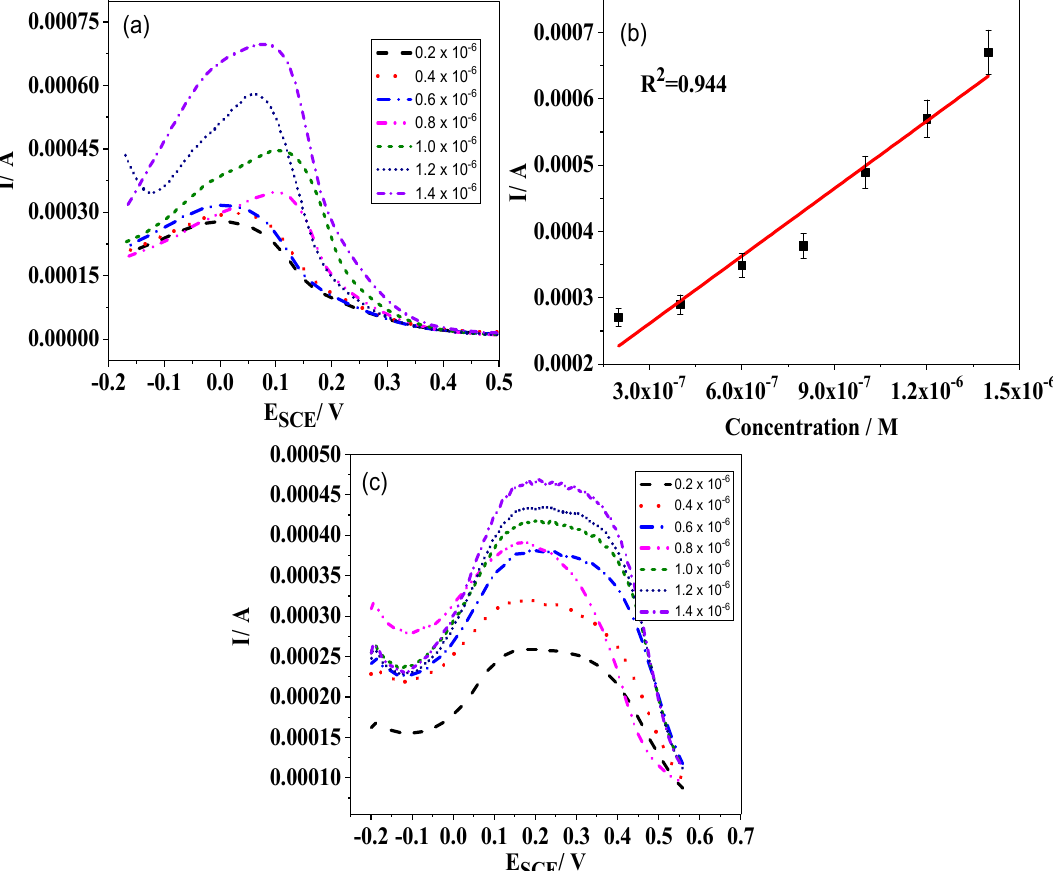
Figure 5. Square wave voltammograms of ( a ) PACHA and ( c ) PANI at different levels of H 2 O 2 concentration; ( b ) shows the response curve of PACHA with H 2 O 2 concentration ranges from 2 × 10 − 7 to 1.4 × 10 − 6